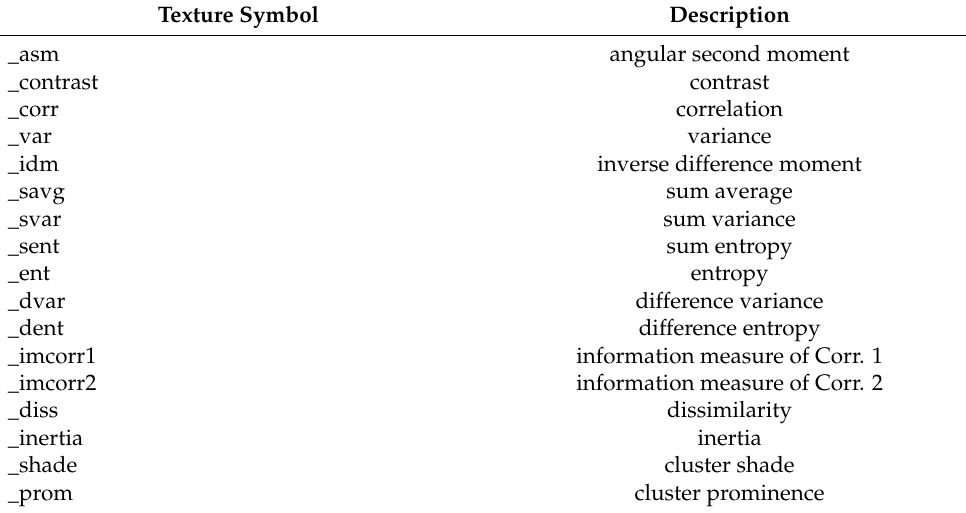
Table 2. The 17 types of textural features calculated in this study.